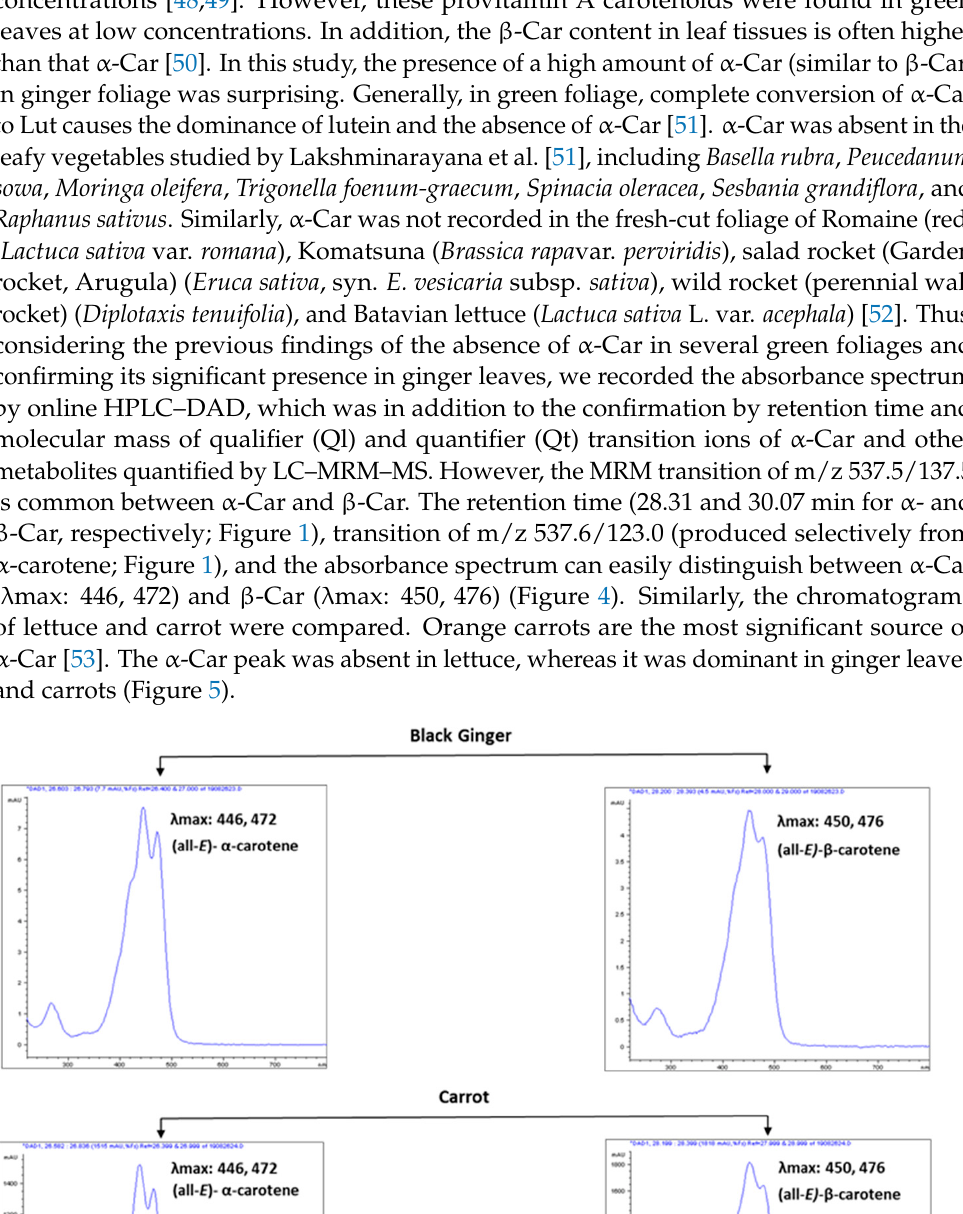
Figure 5. HPLC analysis of pigments in black ginger, carrot, and lettuce. (1) (all-E)-Violaxanthin; (2) (all-Z)-Neoxanthin; (3) (all-E)-Lutein; (4) (all-E)- α -carotene; (5) (all-E)- β -carotene; Chl: chlorophyll. To the best of our knowledge, there are no reports on the fatty acid profile of KP-BG. In this study, the fatty acid composition of KP-BG leaves was examined using GC–FID/MS for the first time. α -Linolenic acid was found (39.68–43.12%) to be the most abundant fatty acid in KP-BG leaves (Table 2). Similarly, α -Linolenic acid was identified as the predomi- nant fatty acid in the leaves of Mertensia maritima [39], Aronia melanocarpa [45], Sedum da- syphyllum [46], and Ajuga multiflora [60]. In the in-vitro-raised KP-BG leaves, the propor- tion of oleic acid (OA) decreased, and that of linoleic acid (LA) increased. A reverse trend